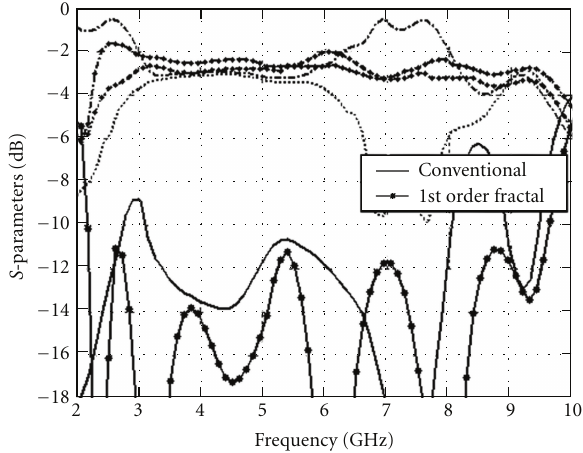
Figure 2: Scattering S11 ( — ), S21 ( −· ), and S31 ( ··· ) parameters of the conventional branch line coupler and 1st-order Minkowski branch line coupler.